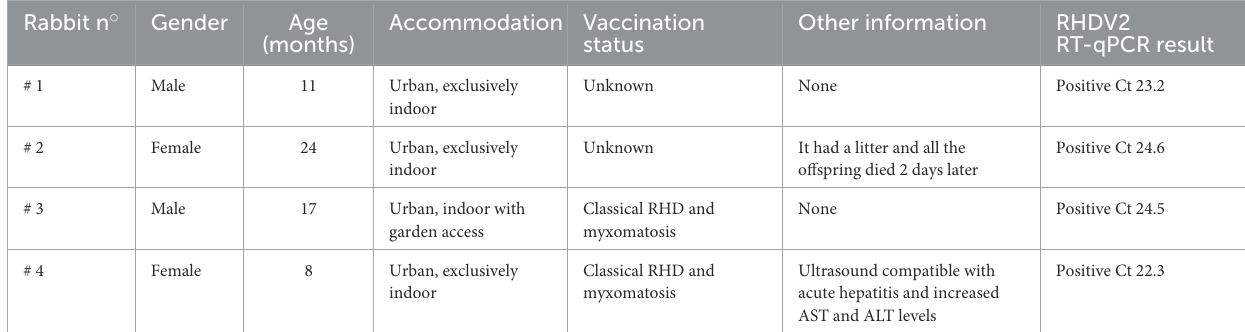
TABLE 1 General information of the pet